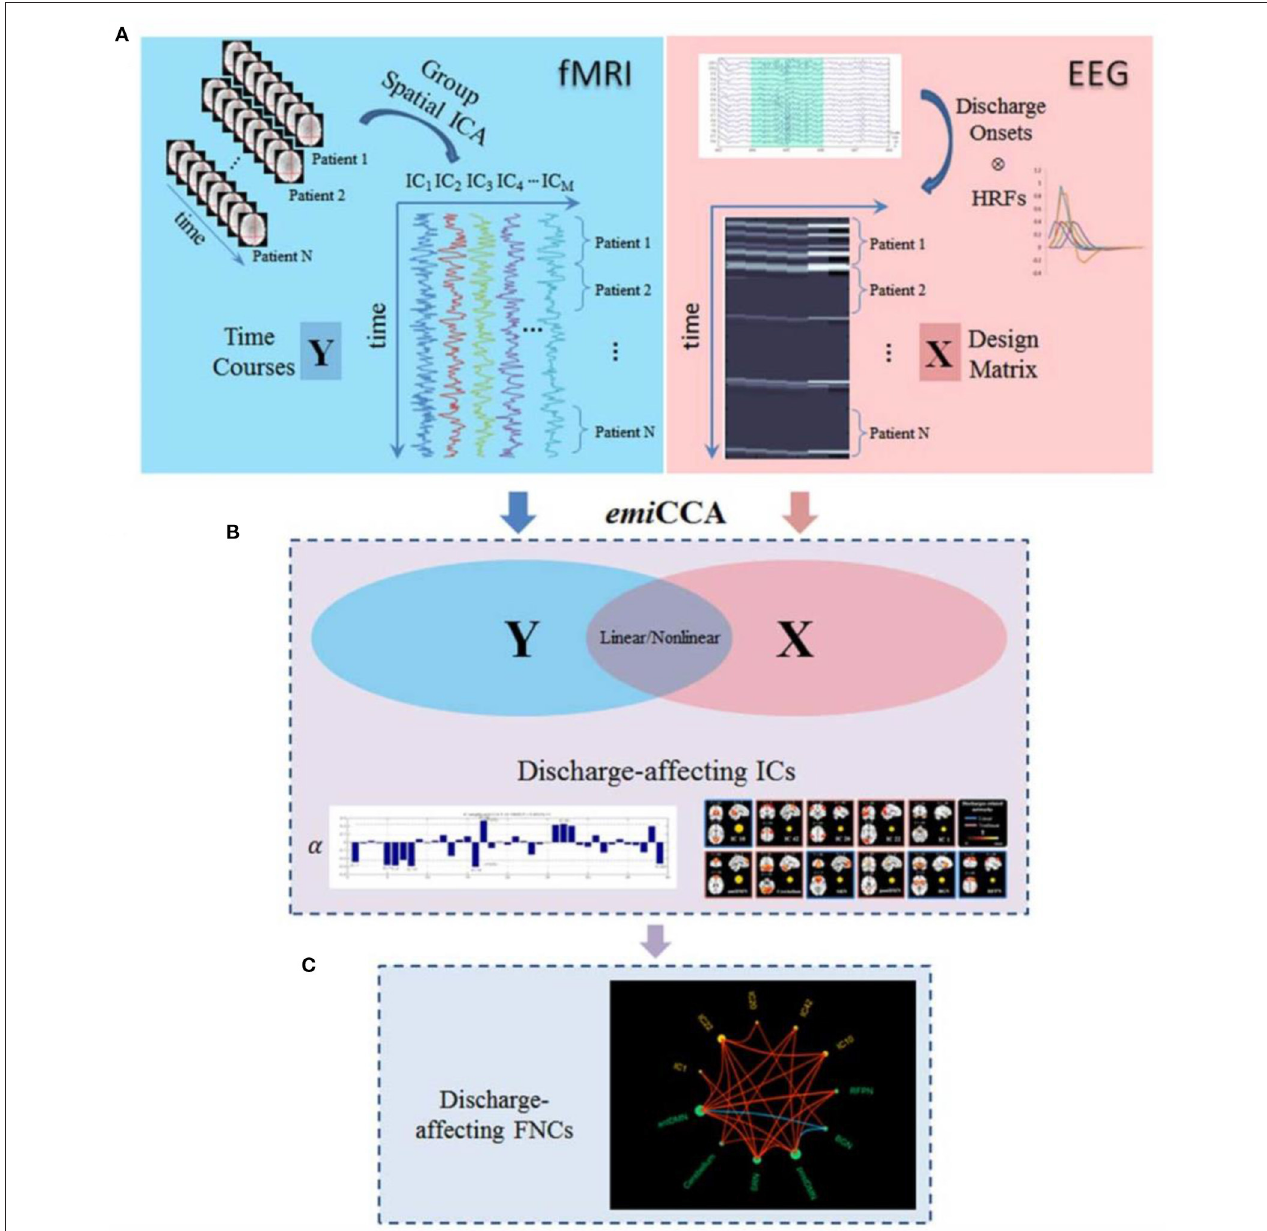
FIGURE 9 | The framework of discharge-affecting network analysis using emiCCA. (A) Dataset Y was defined by applying group ICA to fMRI data and concatenating the ICs across the patients. Also, after identifying the onsets of GSWDs by neurologists and convolving with four SPM canonical HRFs peaking at 3–9s, one Glover HRF, and one single Gamma HRF, a design matrix containing all of them formed the dataset X. (B) The emiCCA was applied for identifying significant linear and non-linear discharge affecting ICs with weights ( α ) exceeding the 1.5 standard deviations of weight values corresponding to the significant maximal information Eigen coefficients (MIECs). (C) For examining the possible functional network connectivity between the networks identified by emiCCA, the maximal time-lagged correlation method was used (122).